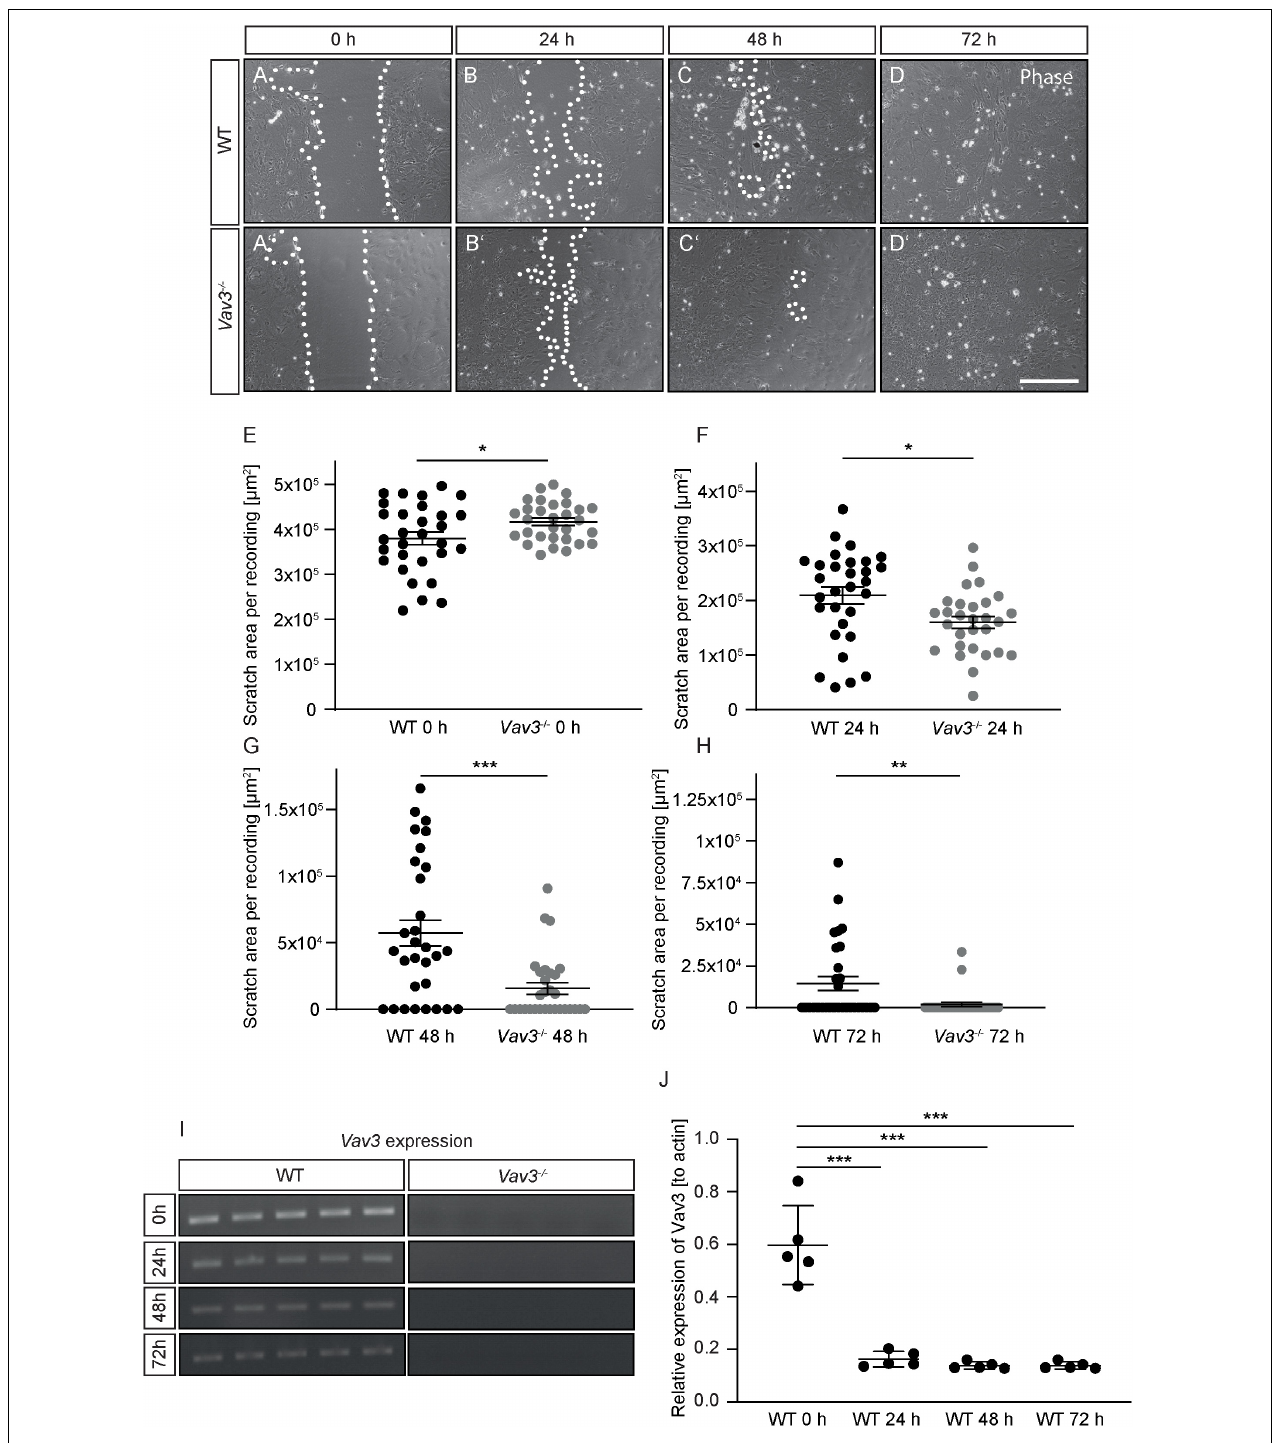
FIGURE 6 | (A–D,A’–D’) Wildtype and Vav3 − / − astrocytes were tested regarding their migration behavior in a scratch wound healing assay. Phase contrast images were taken immediately after performing the scratch (0 h) and after 24, 48, and 72 h. (E–H) The scratch area was visibly smaller in the Vav3 − / − astrocyte cultures after 24 and 72 h, although the initially performed scratch was greater in these cultures. (I) RT-PCR analysis confirmed the absence of Vav3 − / − in cultured astrocytes. (J) Furthermore, the expression of Vav3 was significantly reduced in wildtype cultures after performing the scratch. Statistics: In total, five experimental repetitions ( N = 5) were performed for the scratch wound healing assay. Here, 6 phase contrast images ( n = 6) were recorded and quantified per experimental repetition. For the Vav3 RT-PCR also five experimental repetitions ( N = 5) and one sample per preparation ( n = 1) were used. Unpaired t -test, * p ≤ 0.05, ** p ≤ 0.01 and *** p ≤ 0.001, data are represented as mean ± SEM. Scale bar: 200 µ m.